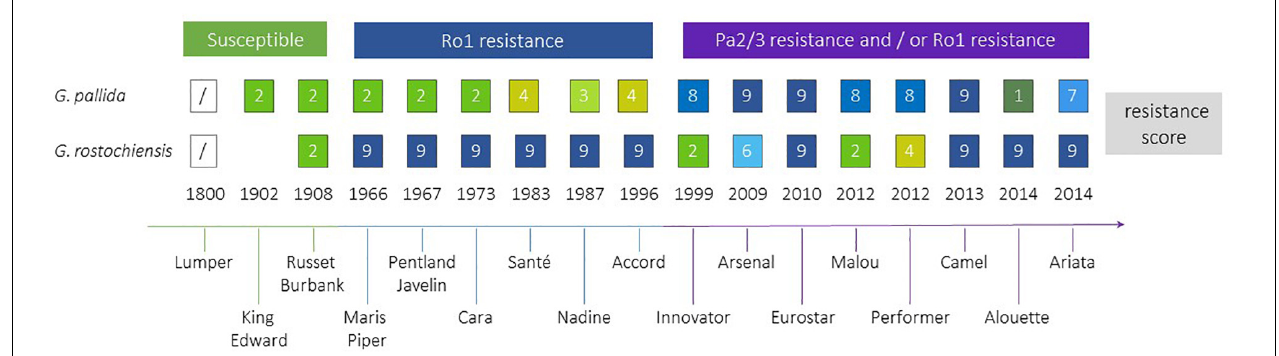
FIGURE 4 | Selected potato cultivars, approximate time when they became commercially available, the introduction of resistances to Globodera rostochiensis and G. pallida . H1 resistance is used in all above cultivars against G. rostochiensis , whereas for G. pallida several sources of resistance have been introgressed. PCN resistance scores from 1 to 9 indicate increasing resistance levels from susceptible (1) to highly resistant (9) (EPPO,